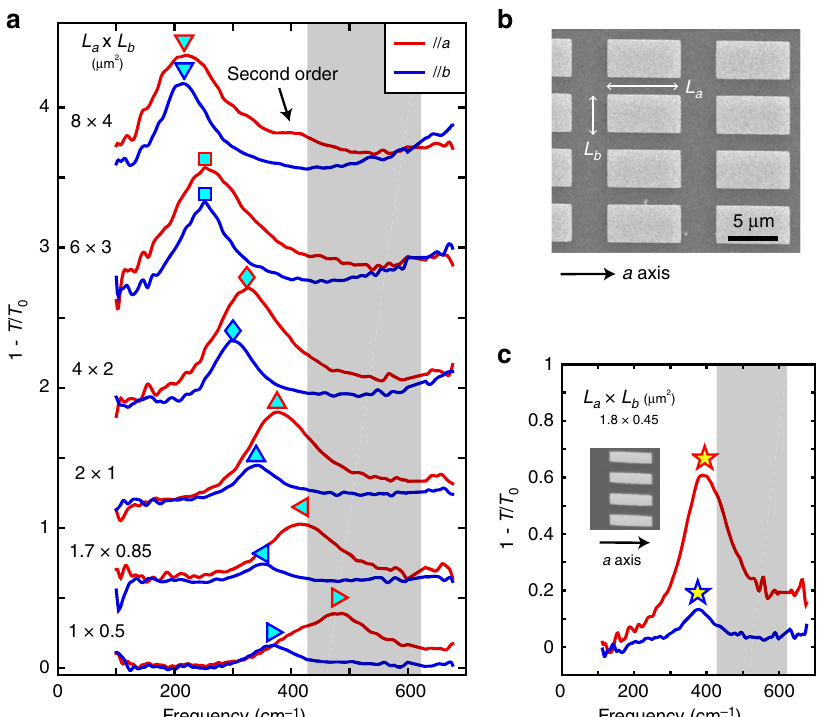
Fig. 3 Plasmon modes in the rectangle arrays on polycrystalline diamond substrates. a Extinction spectra of rectangle arrays with a fi xed aspect ratio L a / L b = 2 with polarization along a and b axes at 10 K. Offset for clarity. All the fi lms have similar thickness of 100 ± 20 nm. b SEM image of a rectangle array with L a × L b = 8 × 4 μ m 2 . c Extinction spectra of the rectangle array (1.8 × 0.45 μ m 2 ) with polarization along a and b axes. The inset shows the SEM image with scale bar of 1 μ m. The shaded area indicates the hyperbolic